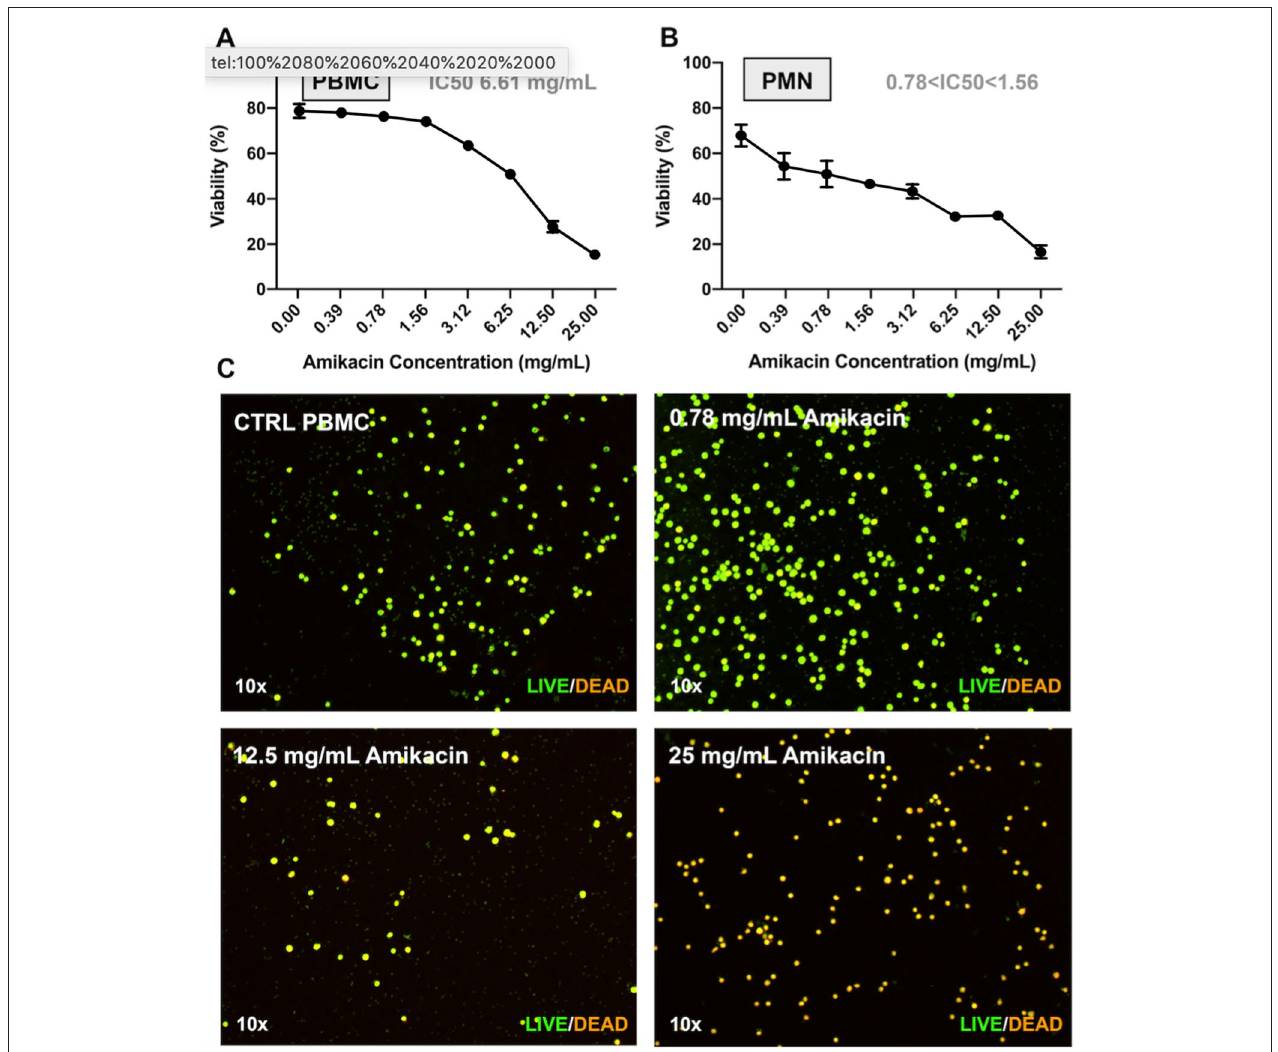
FIGURE 7 | Effect of amikacin on neutrophils and peripheral blood mononuclear cells at clinically relevant doses. Cytotoxicity of amikacin on (A) peripheral blood mononuclear cells (PBMCs) and (B) polymorphonuclear cells (PMNs) derived from whole blood of three horse donors each in triplicate and assessed by Trypan blue dye exclusion over a range of amikacin concentrations. The inhibitory concentration 50 (IC 50 ), or the concentration at which 50% of the cells were dead, is denoted. (C) Live/dead visualization of PBMCs following amikacin exposure over a range of doses reached clinically (0.78, 12.5, and 25 mg/ml) performed using the LIVE/DEAD Viability and Counting Kit (Thermo Fisher